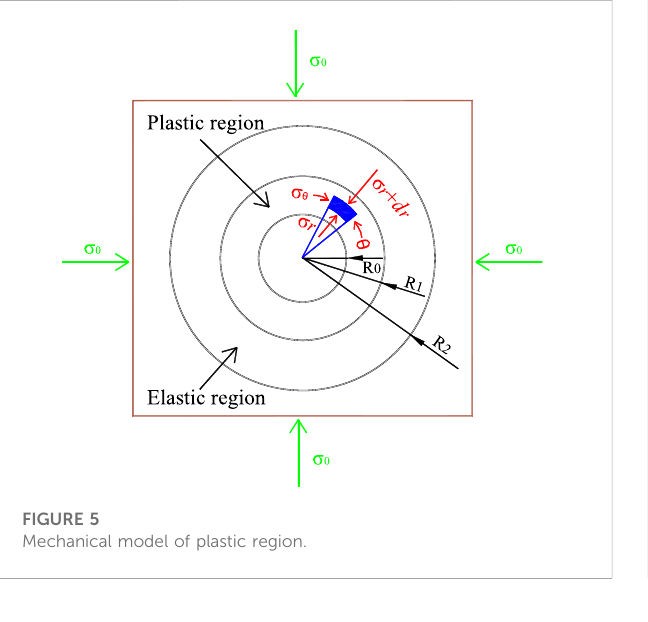
FIGURE 5 Mechanical model of plastic region.